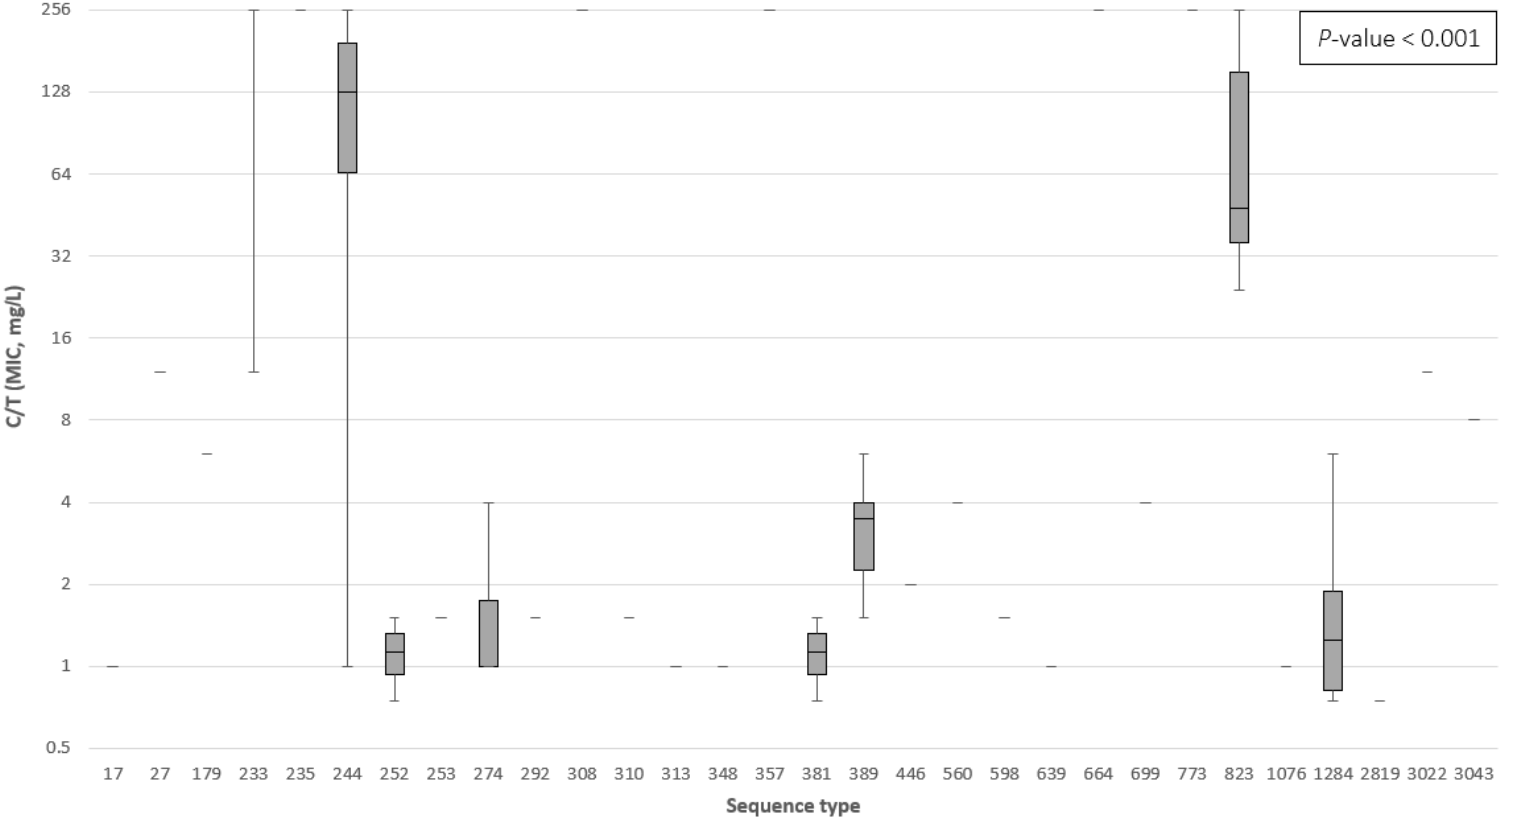
Figure 1. ( a ) Sequence types of MDR- P. aeruginosa were correlated to the MIC values of ceftazidime–avibactam (CZA). The P -value was measured only for those sequence types with at least two MIC values using the non-parametric Kruskal–Wallis test. All MIC values ≥ 256 mg/L were set to the maximum measurable MIC of 256 mg/L for this analysis. ( b ) Sequence types of MDR- P. aeruginosa were correlated to the MIC values of ceftolozane–tazobactam. The p -value was measured only for those sequence types with at least two MIC values using the non-parametric Kruskal–Wallis test. All MIC values ≥ 256 mg/L were set to the maximum measurable MIC of 256 mg/L for this